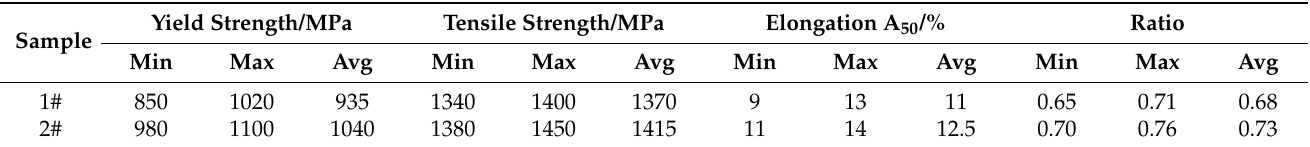
Table 2. Mechanical properties of tested steels.